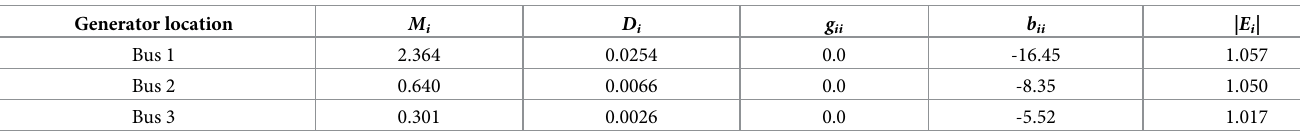
Table 1. Machine data for the IEEE 9-bus system illustrated in Fig 2. Generator